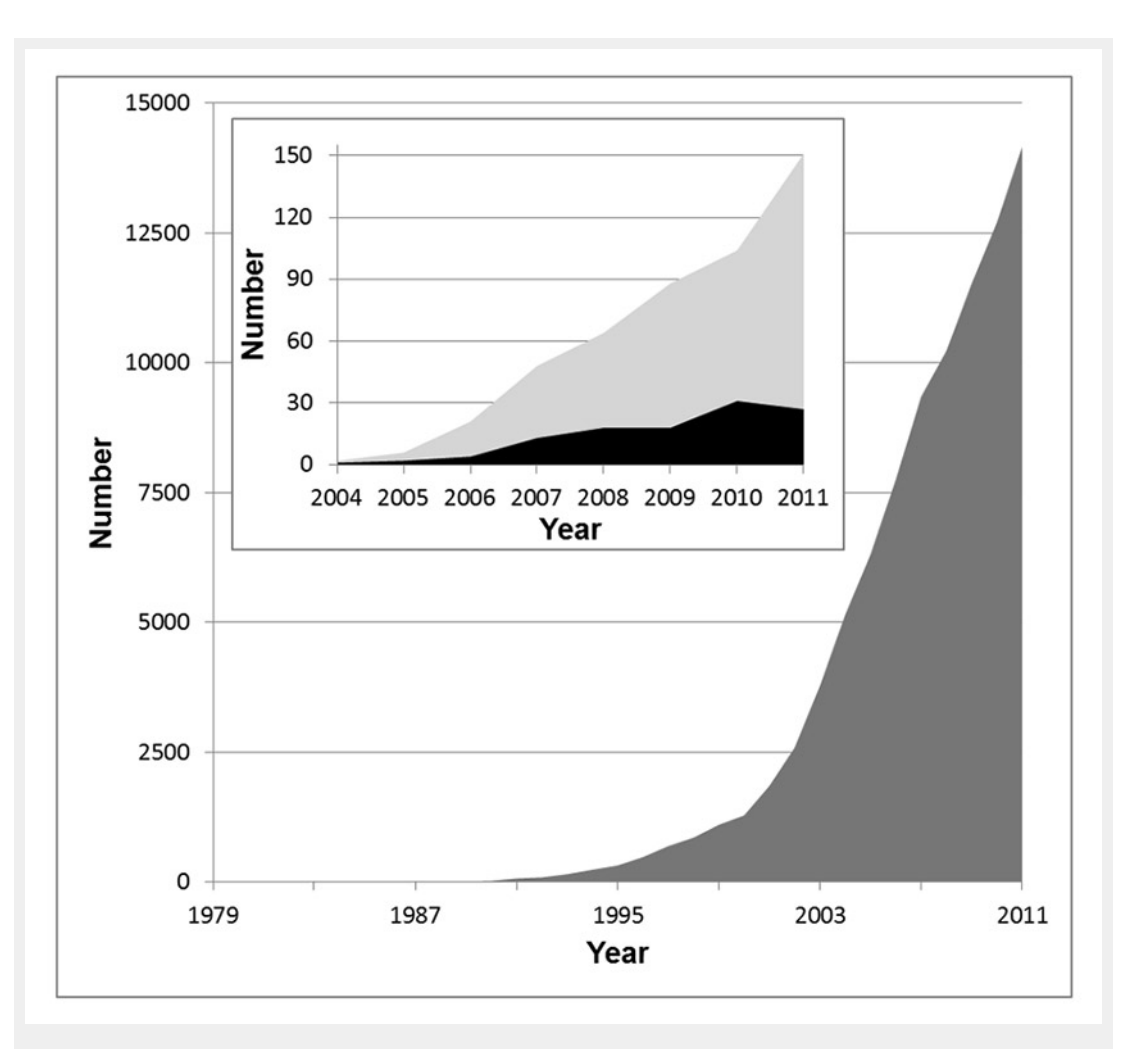
Figure 1 The number of publications in the field of nanotechnology is increasing exponentially. The dark grey area in the main graph depicts the publications per year listed in the ISI Web of Knowledge database (all databases) for the search term “nano”. In the inset, the light grey area shows the search result for the keyword “nanotoxicology” and the black area the hits for “nanotoxicology AND